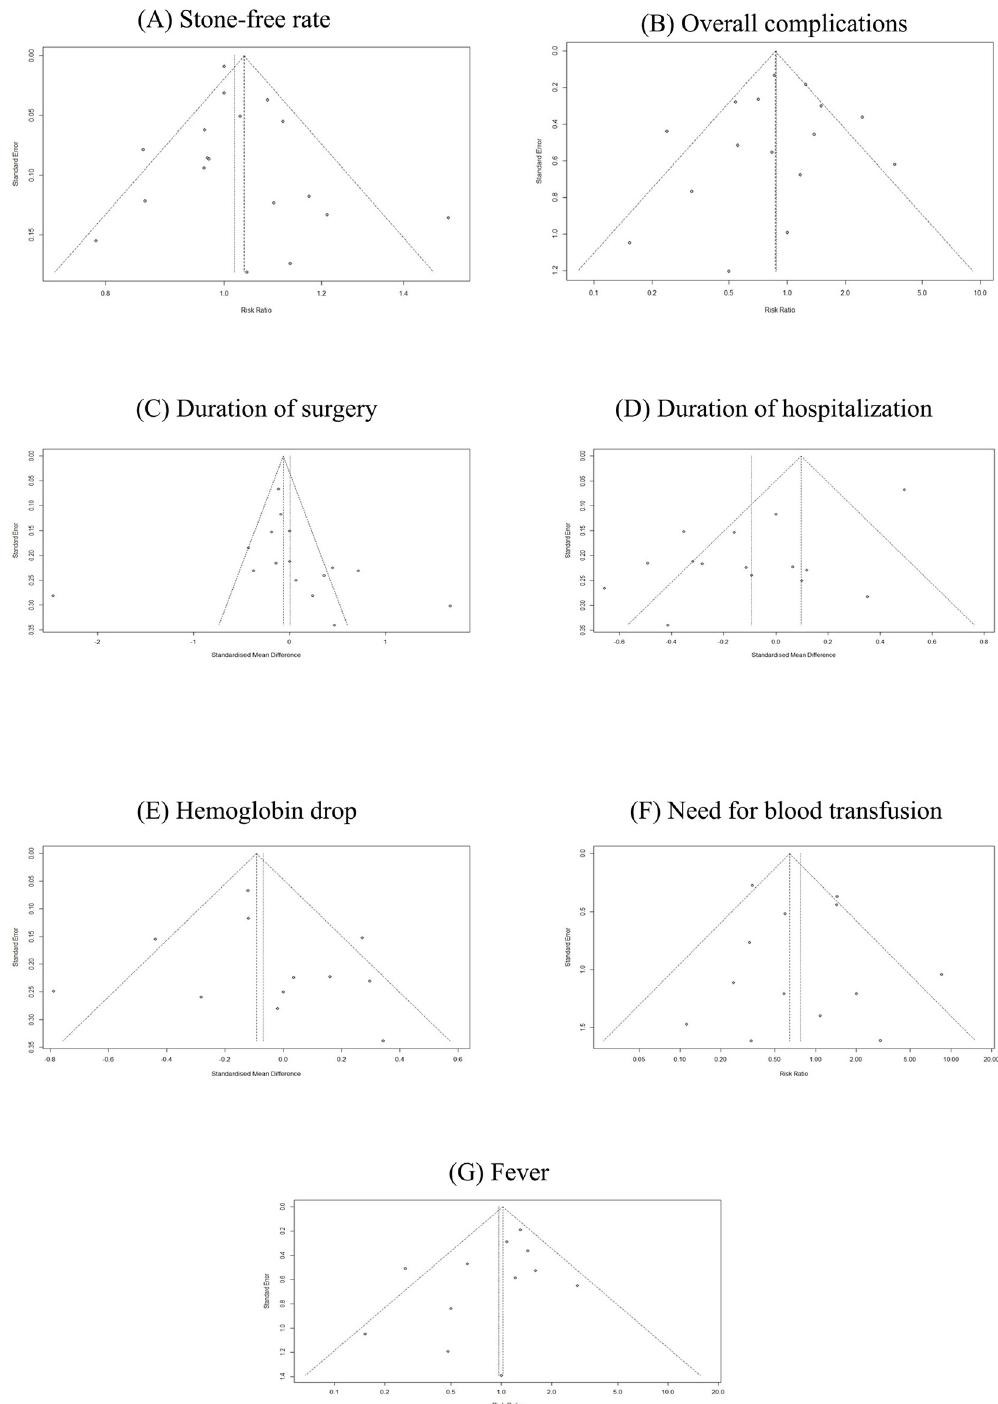
Fig 4. Funnel plots of outcomes reported in at least 10 studies.